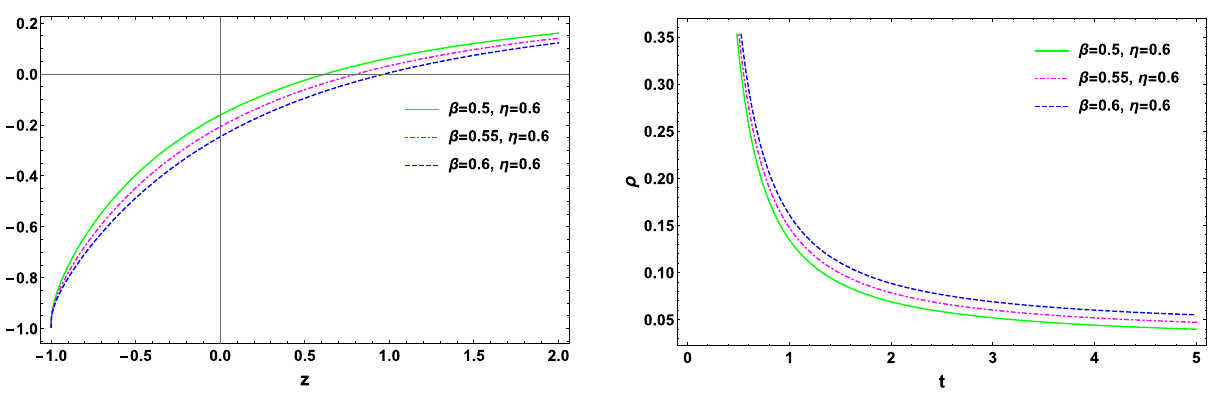
Fig. 13 Variation of EoS Parameter against z with k = 1, γ = − 2, λ = 35